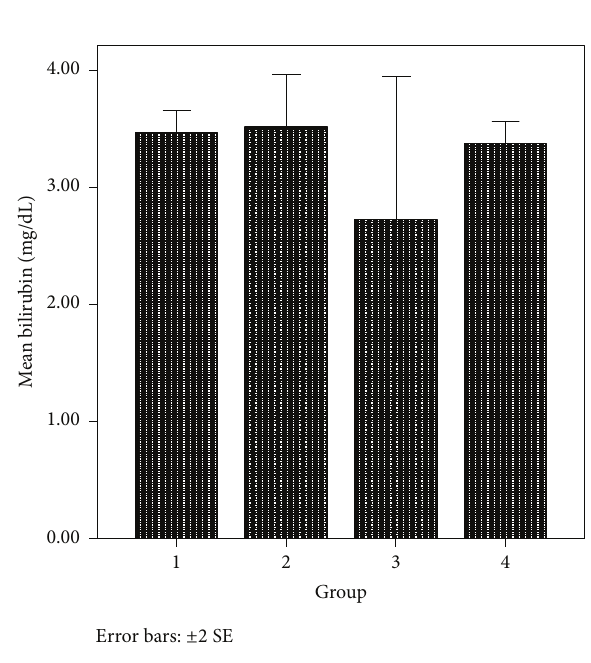
Figure 7: Bilirubin level in various animal